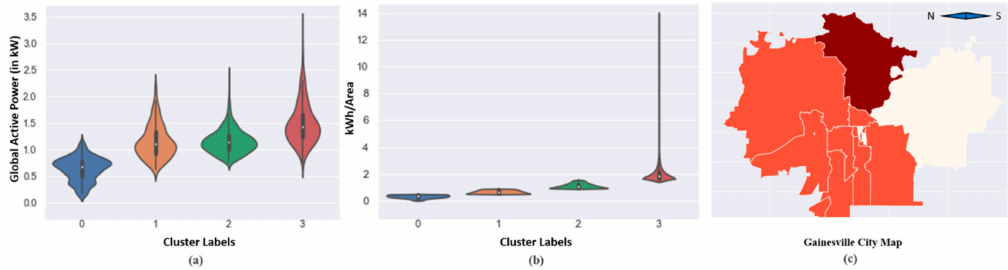
Figure 6. The distribution of samples among the levels of energy consumption. ( a ) Individual household electric power consumption, ( b ) DOE buildings performance dataset, and, ( c ) the map of Gainesville, where each area is a di ff erent color assigned based on the energy consumption of buildings in that area.